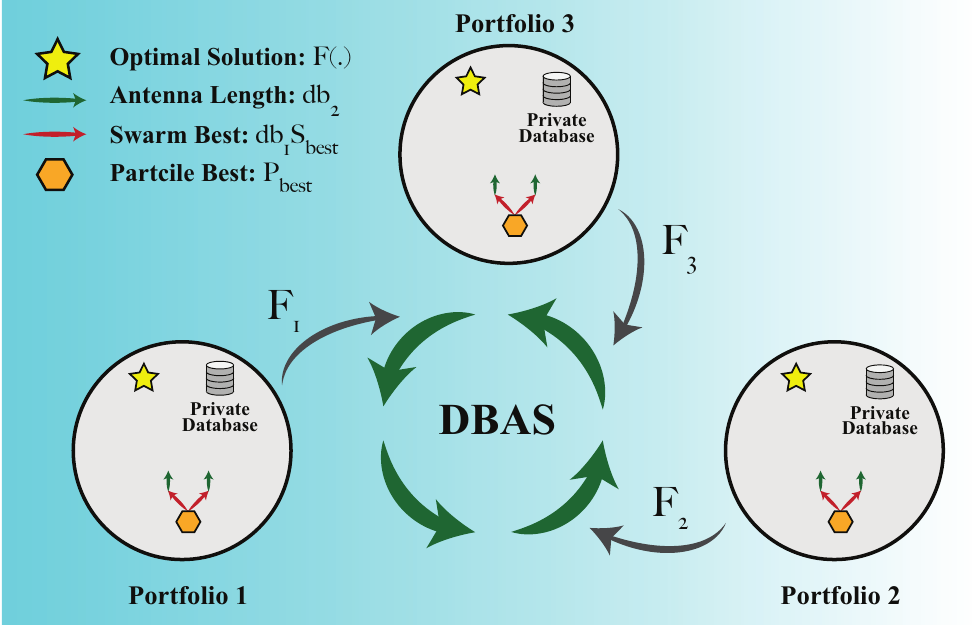
Figure 3. Each particle in DBAS is assigned to a single portfolio, and the particle alone has access to the private database of the portfolio. In DBAS, the particle in swarm only shares the objective function values F , i.e.,